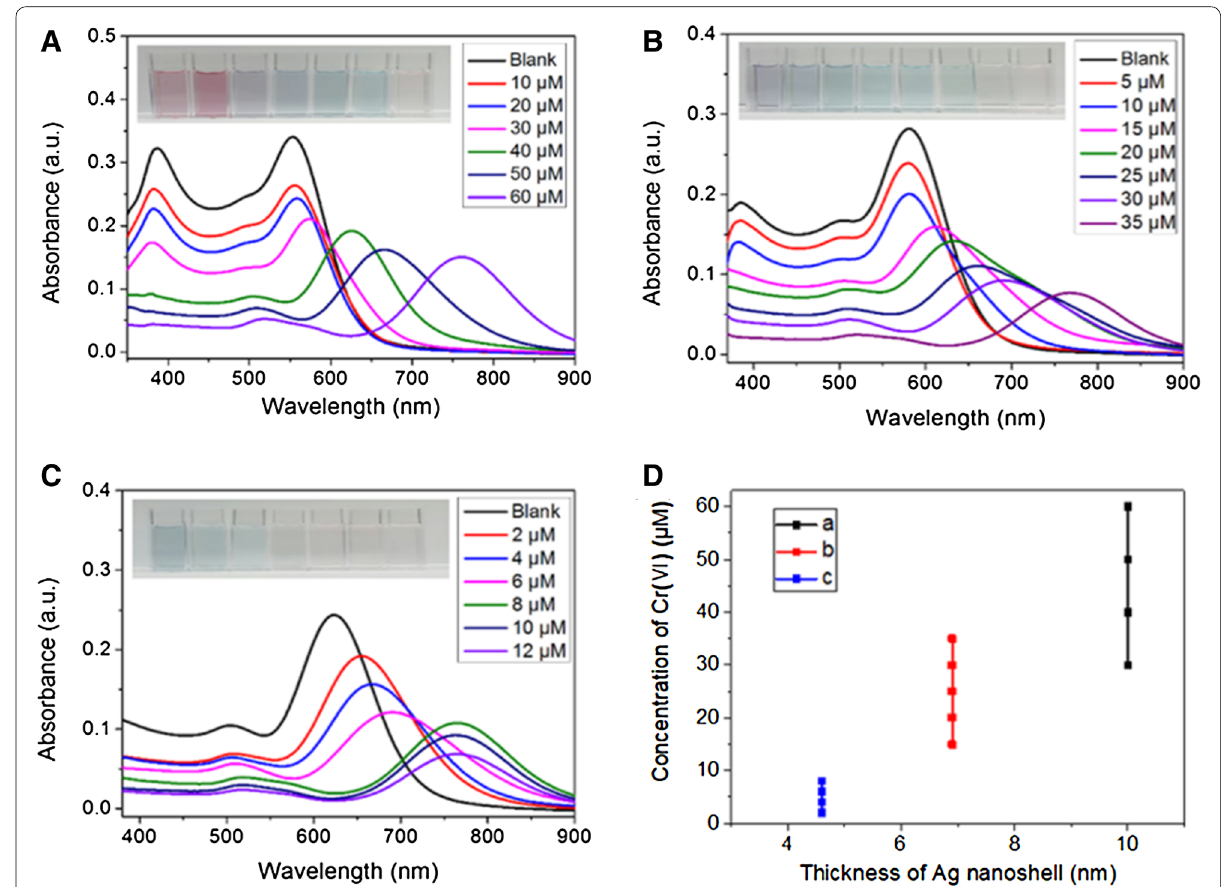
Fig. 4 UV–vis absorption spectra of Au NRs coated with Ag nanoshell of different thickness resulting from adding the different amounts of silver nitrate. The absorption spectra of various concentrations of Cr(VI): a from 10 μM to 60 μM in AuNR@Ag-1 (Au NRs coated with 350 μL of 0.01 M AgNO 3 ), b from 5 μM to 35 μM in AuNR@Ag-2 (Au NRs coated with 250 μL of 0.01 M AgNO 3 ), c from 2 μM to 12 μM in AuNR@Ag-3 (Au NRs coated with 150 μL of 0.01 M